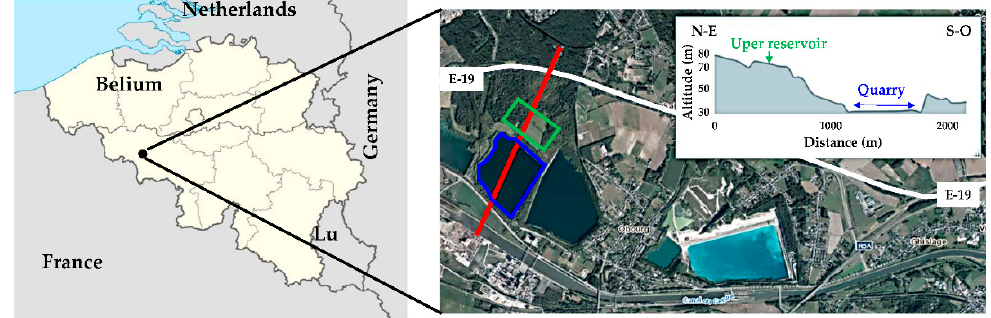
Figure 1. View of the Obourg chalk quarries. The red line, intersecting the studied open pit, gives the location of the altimetric profile.